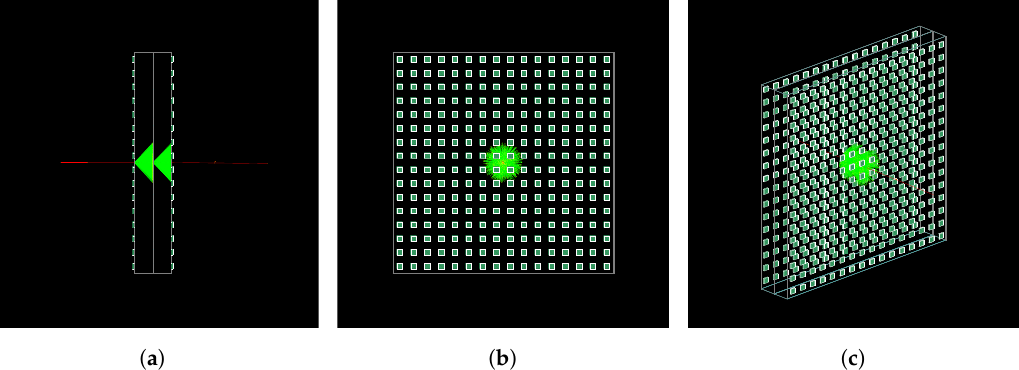
Figure 2. Lateral ( a ), front ( b ) and perspective visualizations ( c ) of event of a muon with 10 5 MeV kinetic energy, simulated in Geant4 for the configuration shown in Figure 1. The optical photons internally reflected at the interface between Plexiglas and air were suppressed to simplify the scene. Respect to Figure 1, Plexiglas and light absorbing foils are drawn only as wire-frame in order to visualize photons trajectories